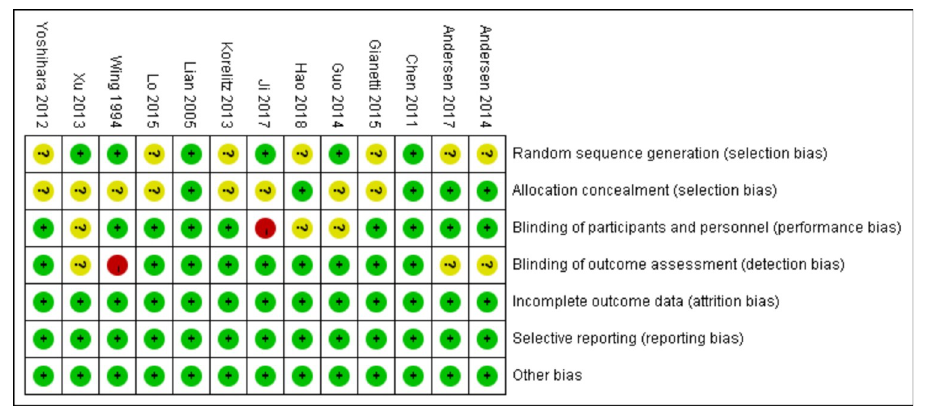
Fig 3. Trial quality assessment.